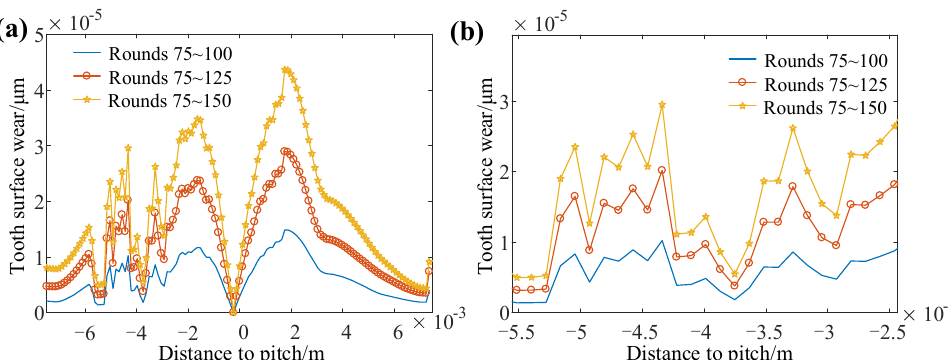
Figure 13. Tooth surface wear with different rounds. ( a ) Tooth surface wear. ( b ) Enlarged diagram of tooth surface wear.